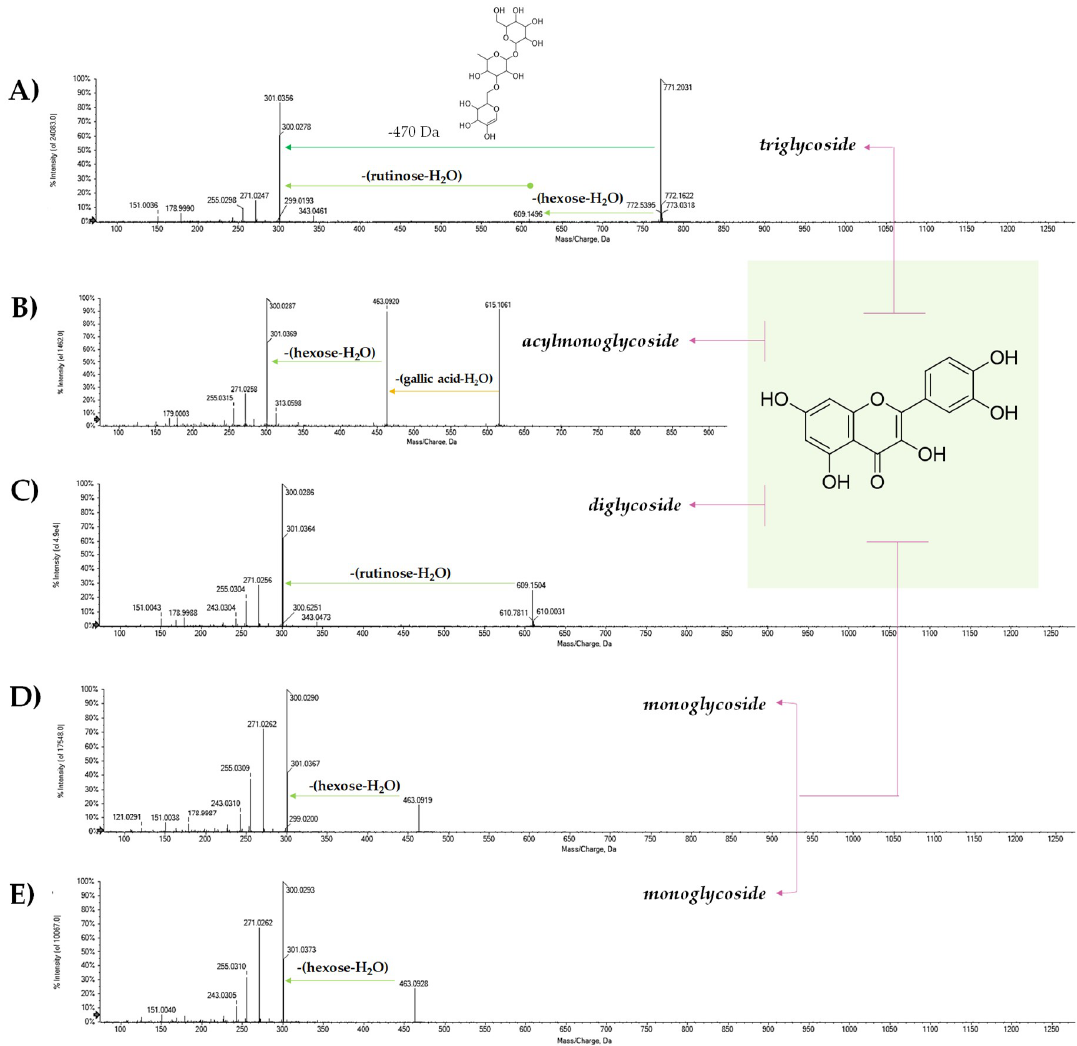
Figure 4. TOF-MS / MS spectra of [M − H] − ion of quercetin glycosides ( A ) 24 , ( B ) 25 , ( C ) 27 , ( D ) 28 , and ( E ) 30 .